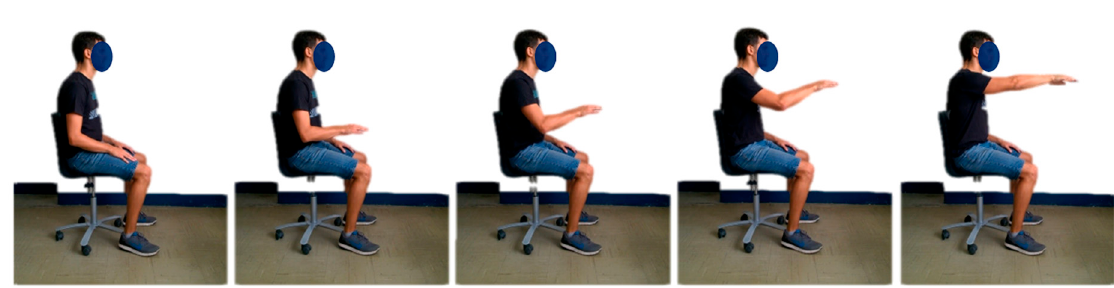
Figure 2. The reaching movement (RM).